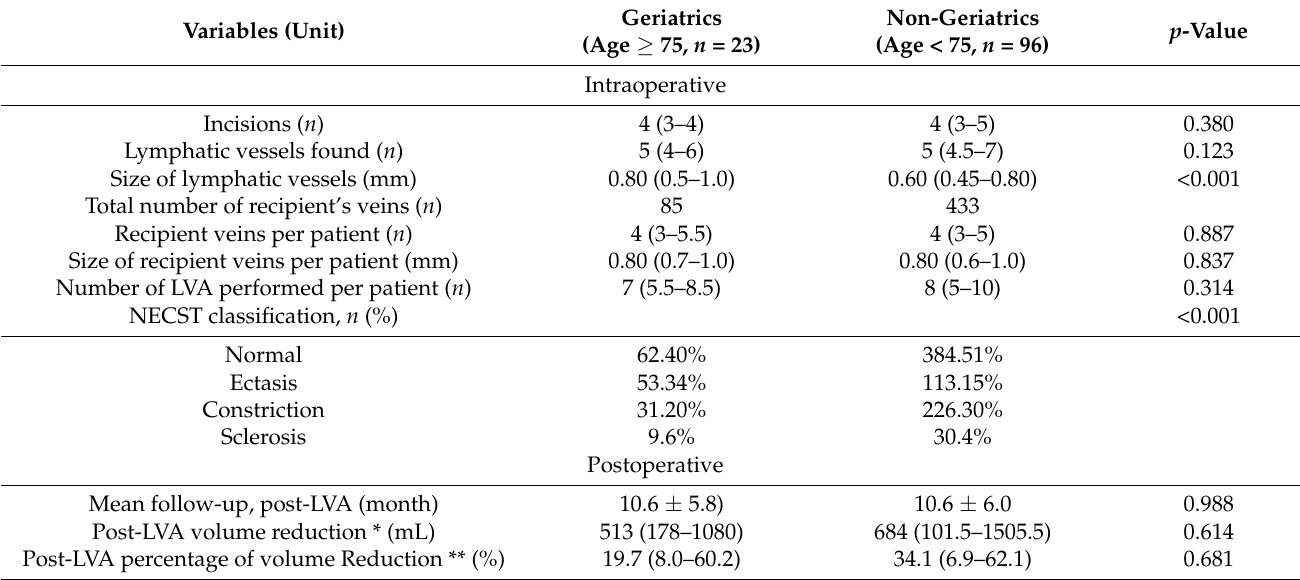
Table 2. Intraoperative and postoperative surgical